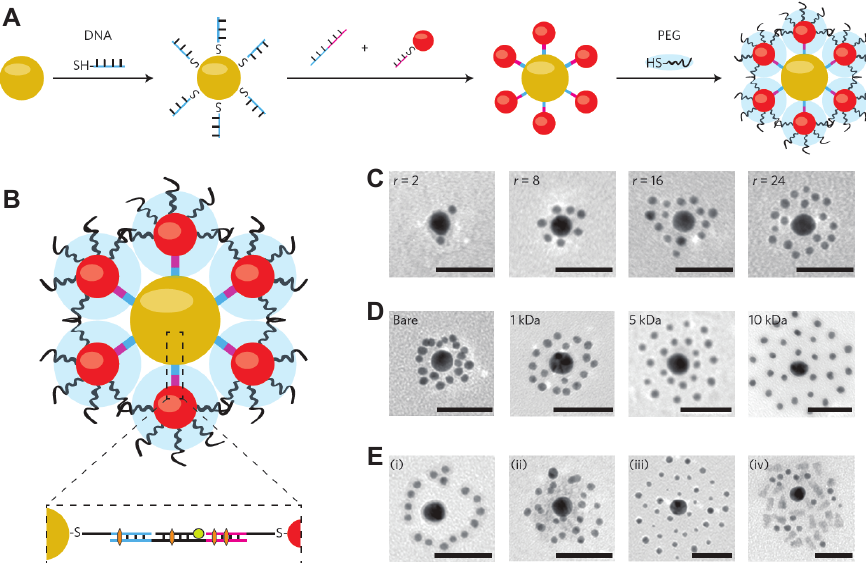
Figure 8. Design of NP superstructure by using the DNA linkers for self-assembly. ( A ) Individual NPs ( red and yellow spheres) were coated with thiolated and single-stranded DNA and then self-assembled together due to the complementary DNA sequence. The surface of the assembled NP can be further decorated by PEG polymers (blue clouds) to control interactions with cells and tissues; ( B ) Cross-sectional view of the self-assembled NP superstructure of a core-satellite. The insert shows that the payloads could be encapsulated either via hybridizing ( green circle) or intercalating ( orange hexagon) to the DNA linkers; ( C ) TEM images of the NP superstructure of two-layer core satellites as a function of the satellite-to-core ratio ( r = 2, 8, 16, and 24); ( D ) TEM images on the NP superstructure of two-layer core satellites as a function of the satellite PEG length (molecular weight M w = bare, 1, 5, and 10 kDa); ( E ) TEM images of the NP superstructure of three-layer core satellites by introducing the third DNA sequence. The scale bars for TEM images are 50 nm. The figure is adapted from Reference [83] with